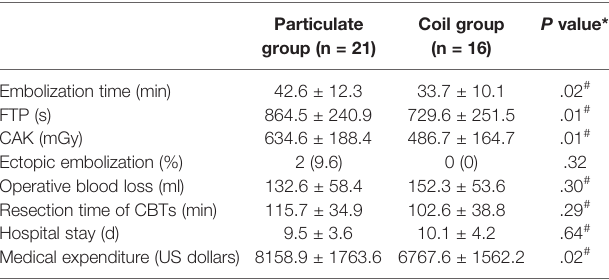
TABLE 2 | Procedure details in particulate and coil groups.